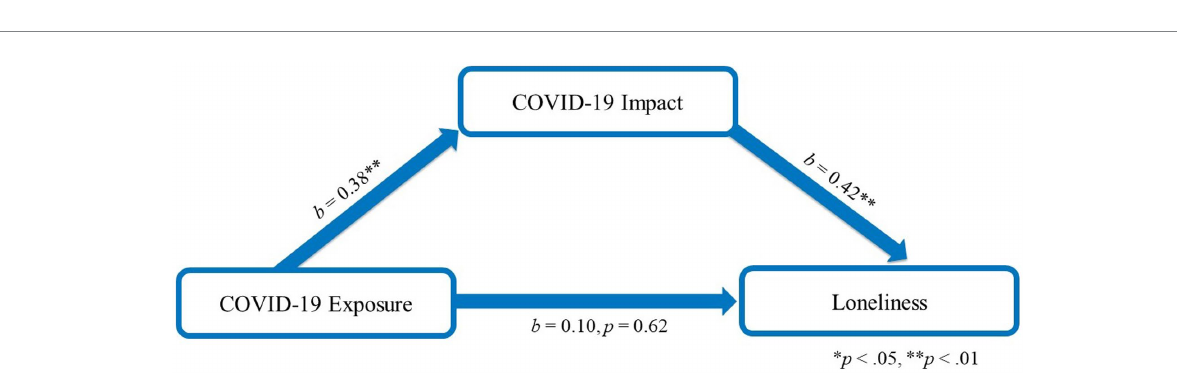
FIGURE 5 Loneliness mediation model. R-squared for the model: 0.10; this model controls for age, gender, ethnicity and prior family income of which gender and age were significantly associated with loneliness total